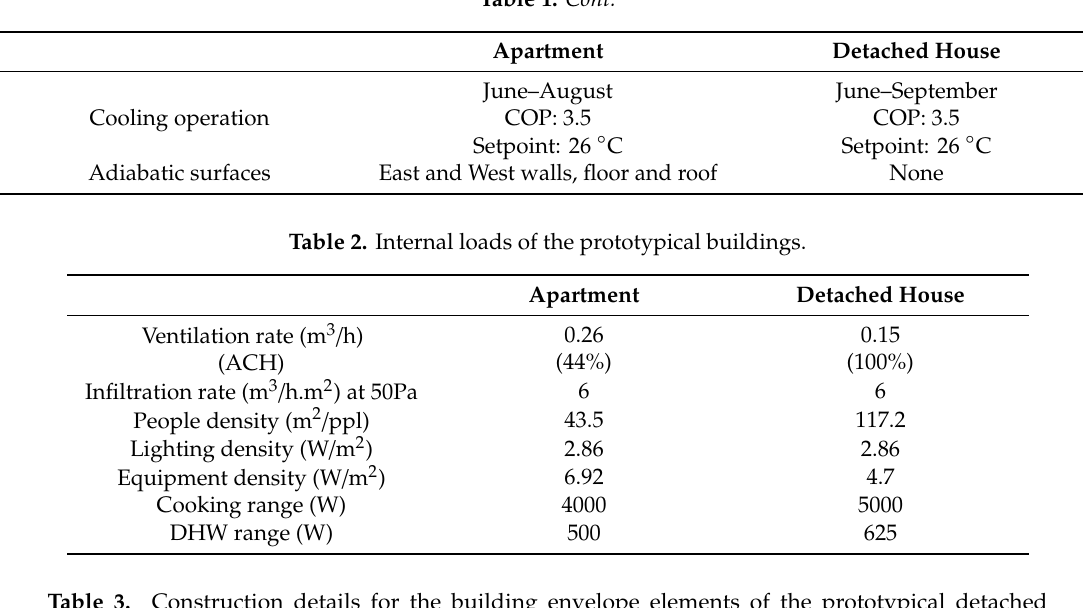
Table 3. Construction details for the building envelope elements of the prototypical detached house